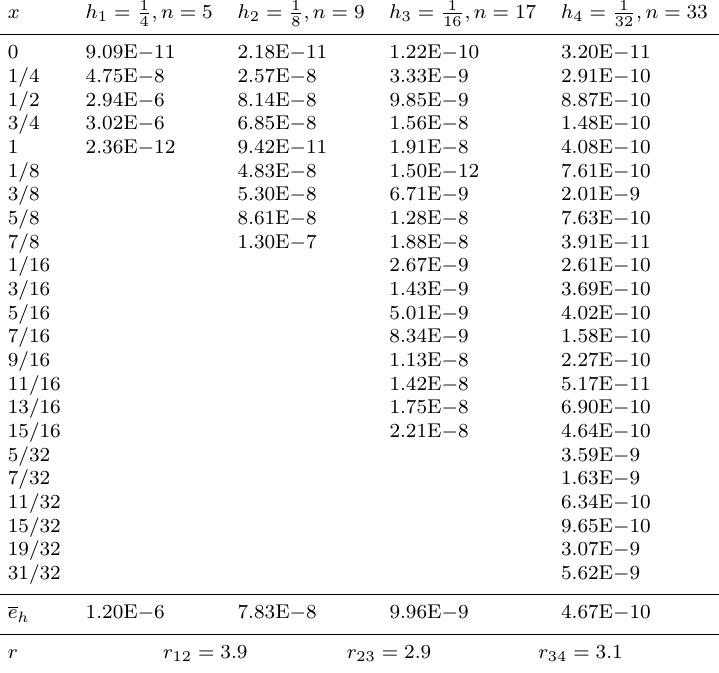
Table 1. The absolute pointwise error and the rate of convergence r for Example 1